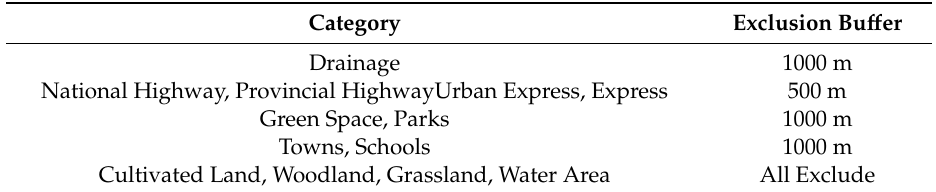
Table 1. Exclusion criteria for areas not suitable for the construction of medical waste disposal